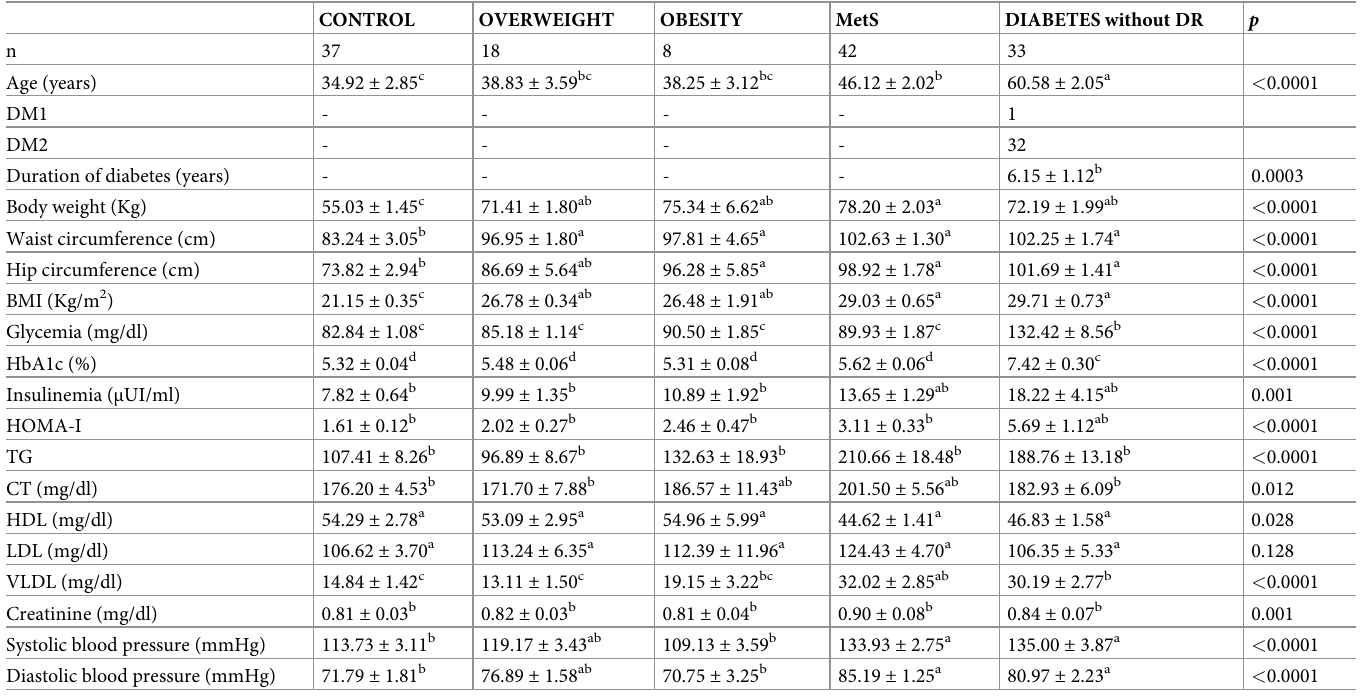
Table 3. Characteristics of the patients studied for external model validation using ERG spectral components from one recording